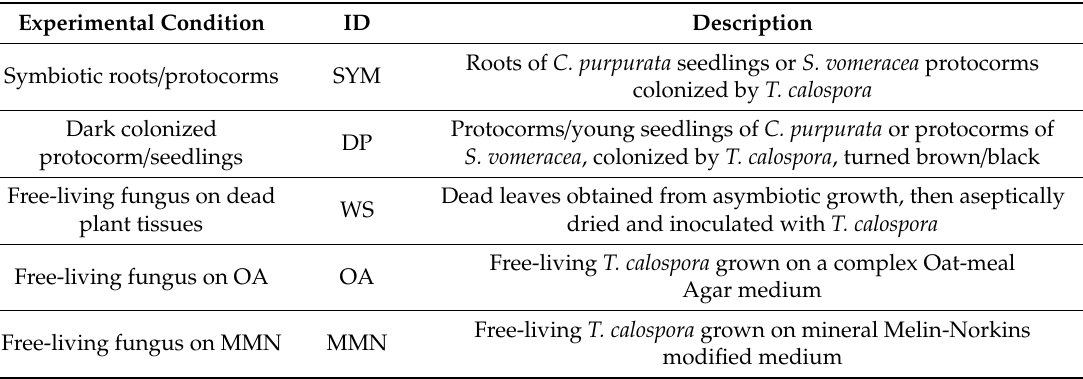
Table 1. Experimental conditions considered in RT-qPCR experiments .